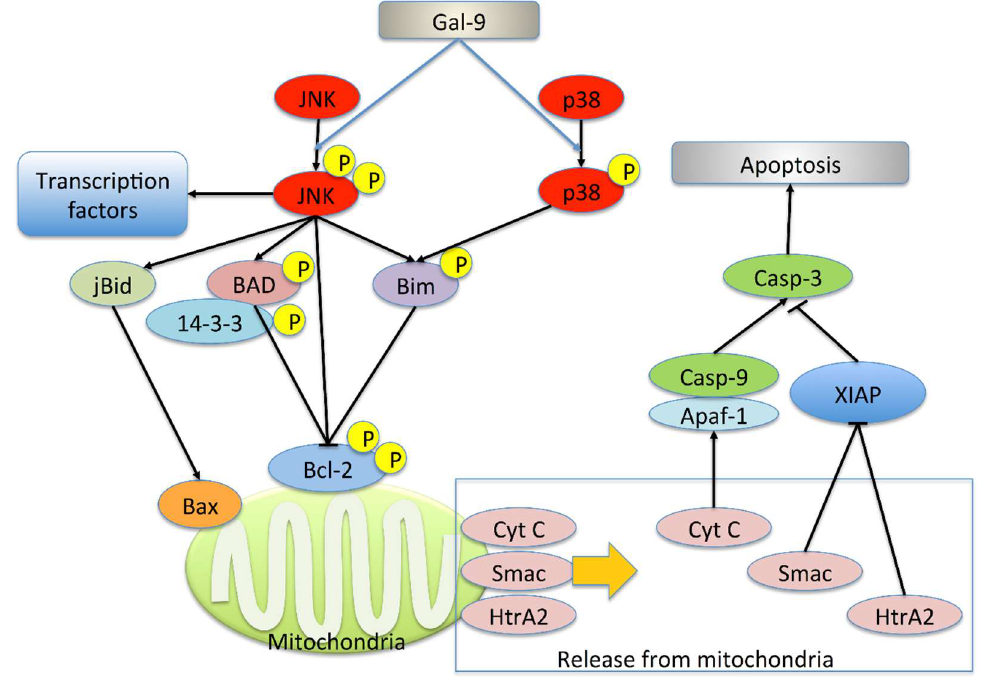
Figure 7. Mitochondria-mediated apoptotic signaling pathway by JNK and p38. Activated JNK promotes the release of cytochrome c (Cyt C), Smac / Diablo (Smac), and HtrA2 from mitochondria via the Bid-Bax–dependent mechanism. Cyt C initiates the activation of the caspase-9–dependent caspase cascade. Smac and HtrA2 inhibit inhibitor of apoptosis protein (IAP) and promotes apoptosis. Furthermore, JNK phosphorylates Bad and its sequestering partner 14–3-3 and promotes Bad-mediated neutralization of Bcl2 family. JNK may also phosphorylate Bcl-2 and inhibit its anti-apoptotic activity. Both JNK and p38 MAPK (p38) inhibit Bcl-2 by phosphorylating Bim. In addition, the activated JNK translocates to the nucleus and activates transcription factors. JNK may promote apoptosis by increasing the expression of pro-apoptotic genes.